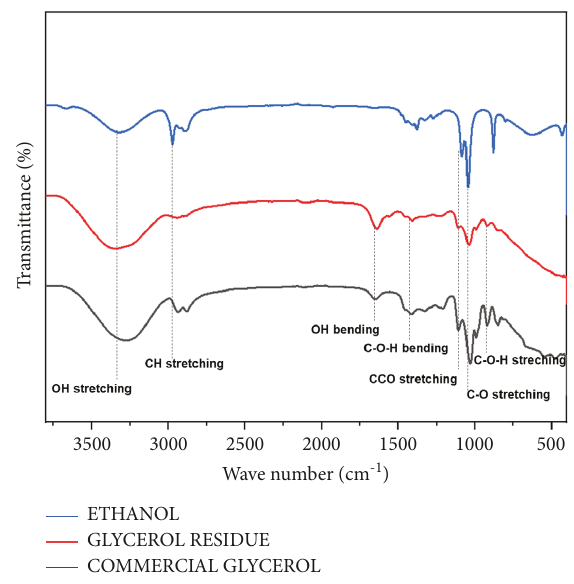
Figure 1: FTIR spectrum of glycerol (commercial), glycerol res- idue, and